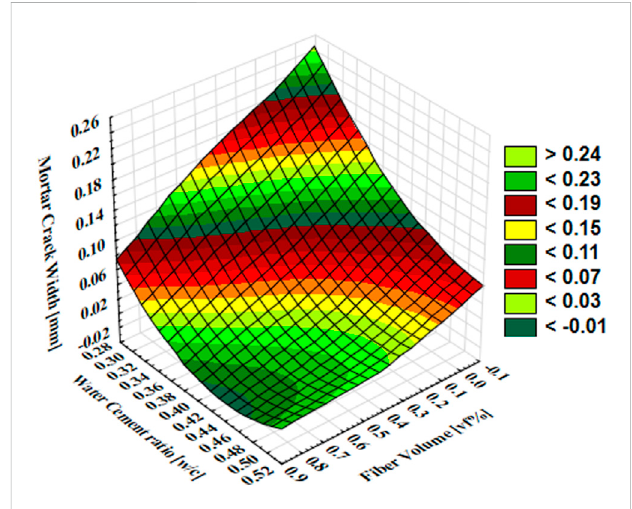
FIGURE 10 Mortar-crack width against fi bre V f and w/c ratio.